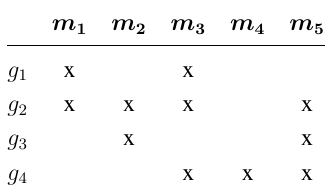
Table 1. Global context.